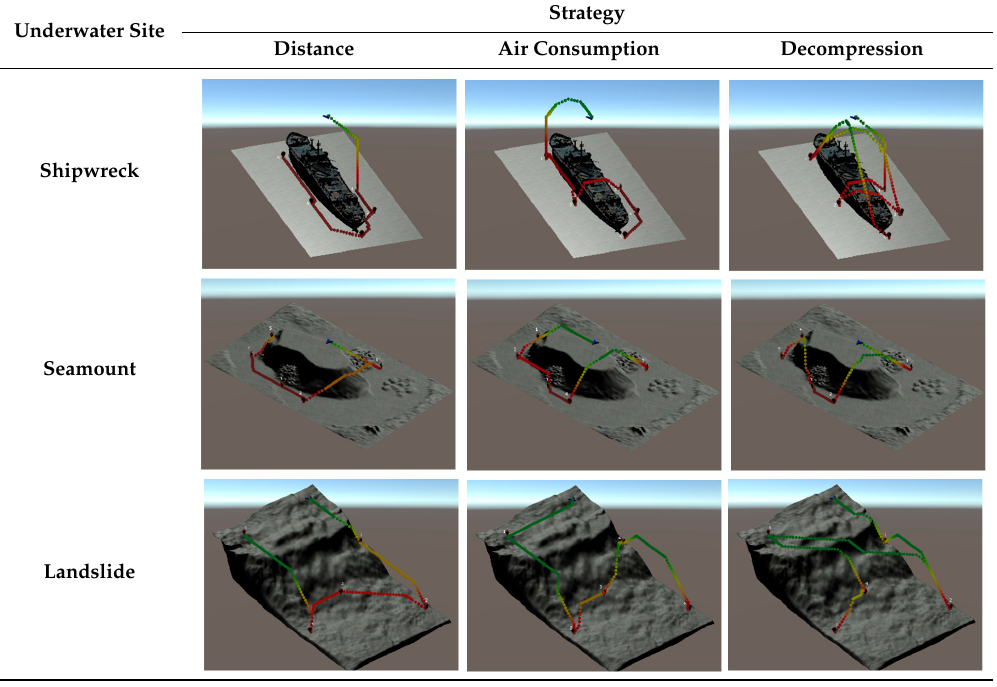
landslide. landslide. landslide.